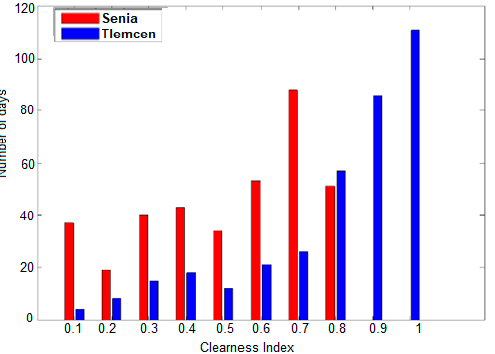
Figure 4. Daily distribution of the clearness index for Senia and Tlemcen.